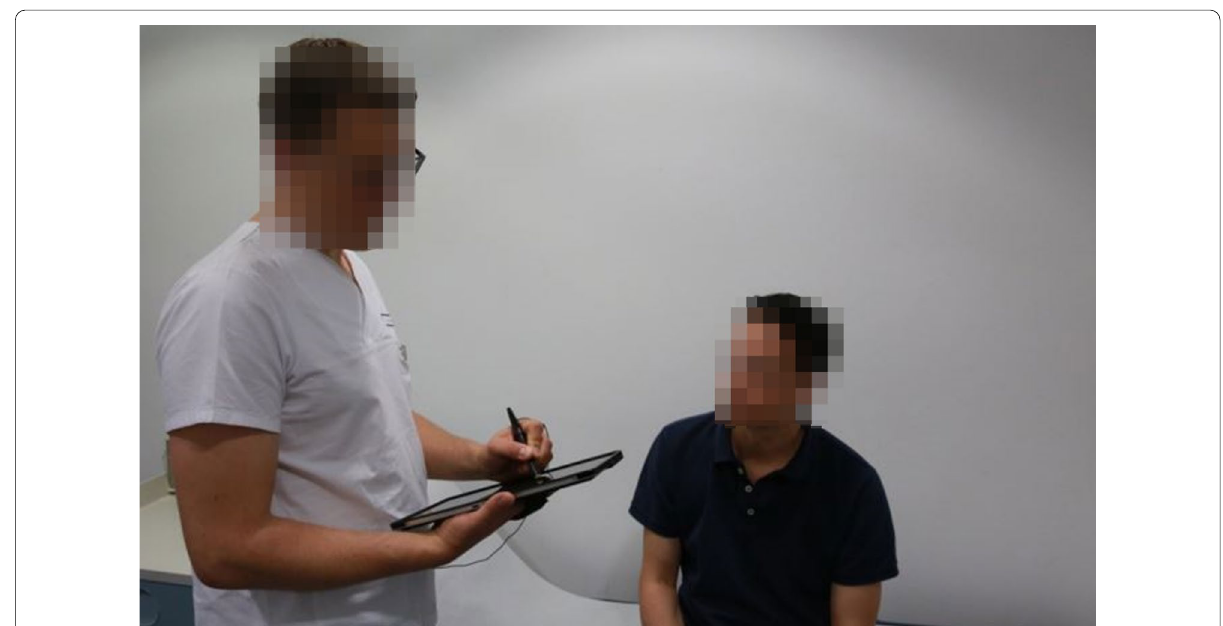
Fig. 2 Digital signature of structured informed patient consent. Each patient and the attending physician digitally signed and confirmed the completeness and validity of the patient data in the preparation